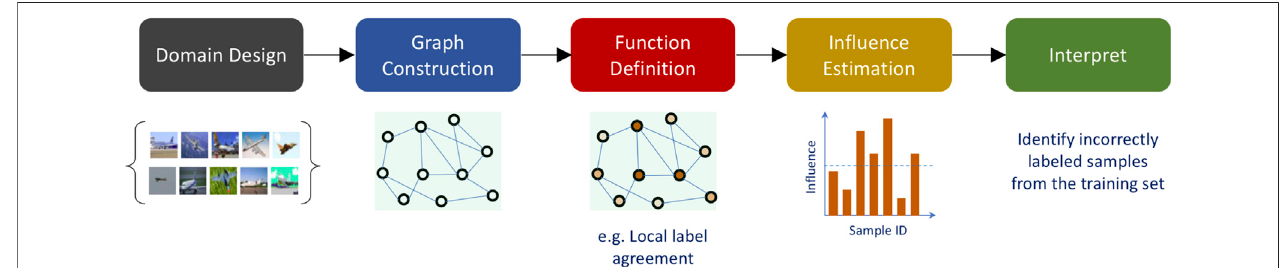
FIGURE1| MARGIN — Anoverviewoftheproposedprotocolforpost-hocinterpretabilitytasks.Inthisillustration,weconsidertheproblemofidentifyingincorrectly labeled samples from a given dataset. MARGIN identi fi es the most important samples that need to be corrected so that fi xing them will lead to improved predictive